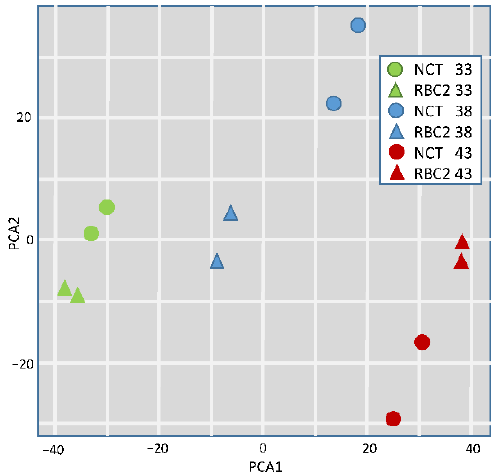
Figure 1. Principal component analysis (PCA) plot of normalized RNAseq read counts. Sample to sample distances (within- and between-treatments) are illustrated for each dataset on the first two principal components. Samples are plotted according to treatment. Table 3. Differential expression of skeletal muscle marker genes in SCs following 48 h of differ- entiation at 38 ◦ C compared to 72 h of proliferation [26]. For each gene, the directional change in gene expression between differentiating and proliferating cells, the fold change (Log 2 FC) and False Discovery Rate (FDR) p -value are given for the comparisons within each turkey line (RBC2 and NCT). Directional expression of genes is indicated by red (up) or green